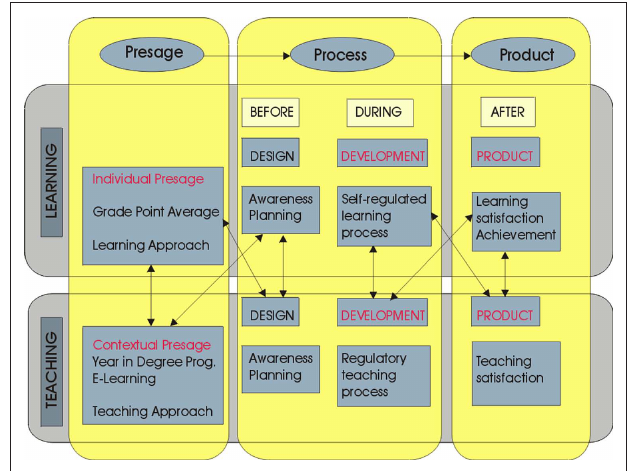
FIguRE 1 | Variables being studied in this investigation (in red),based on the 3P Model (Biggs, 2001) and the DEDEPRO Model (De la Fuente and Justicia,